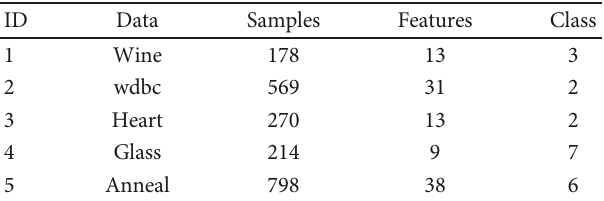
Table 3: Data description